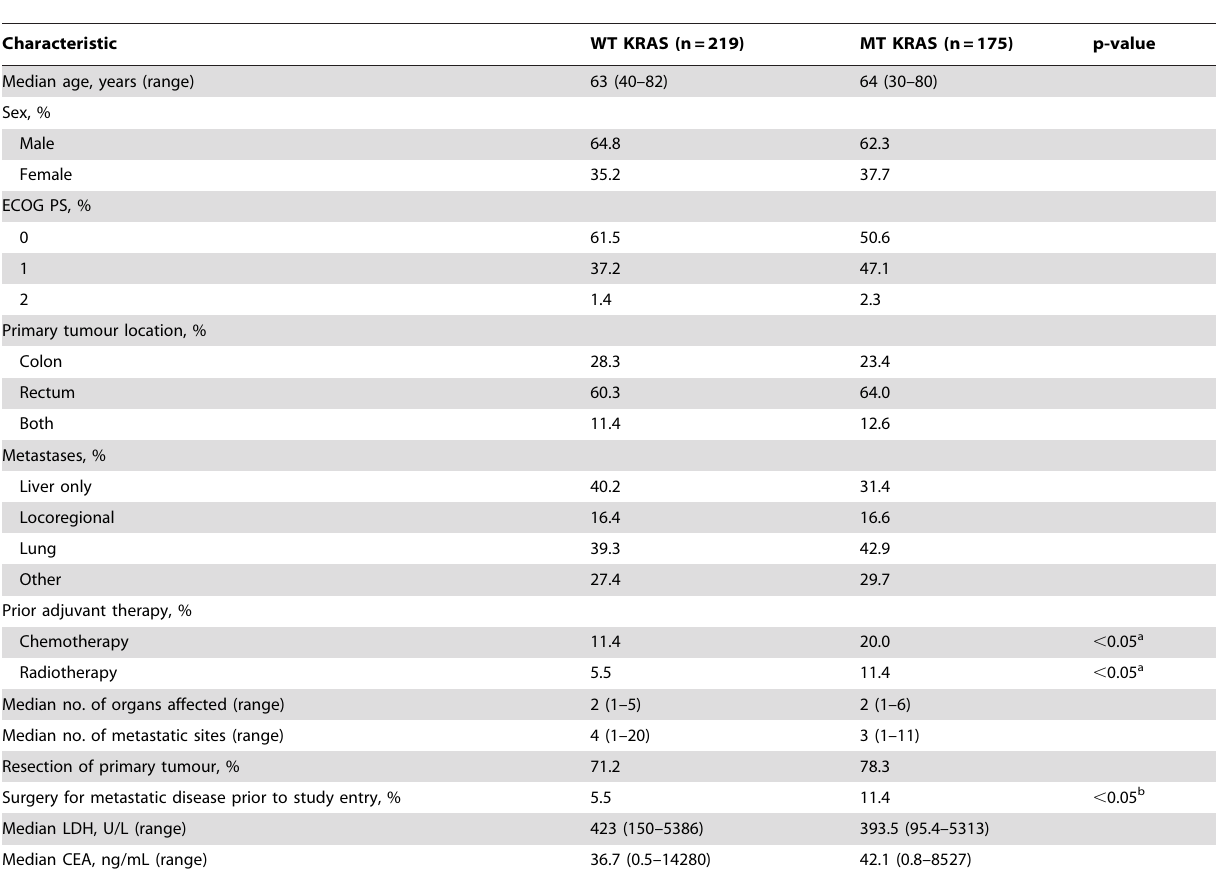
Table 1. Baseline characteristics of patients included in the KRAS analysis according to tumour KRAS status (n=394).